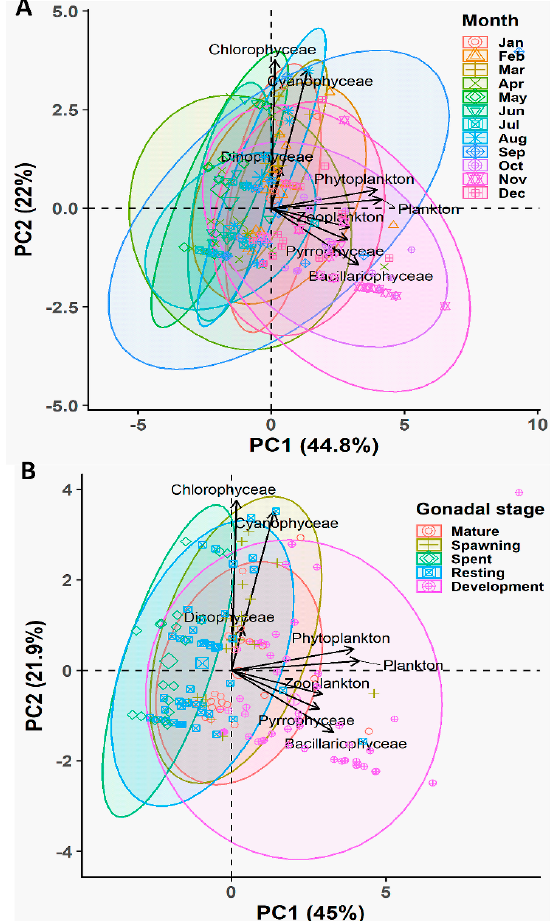
Figure 8. Biplot of principal component analysis (PCA) of the major groups of the ingested gut plankton at different months ( A ) and different gonadal stages ( B ) of green mussel Perna viridis collected from the coastal waters of Bangladesh during November 2017 to October 2018. The PCA of the monthly variation of the gut content analysis consisted of the 20 replicated green mussels for each month (n = 240), whereas the PCA of the different gonadal stages consisted of 37 mature, 34 spawning, 30 spent, 79 resting, and 60 developing stage green mussels (n = 240).